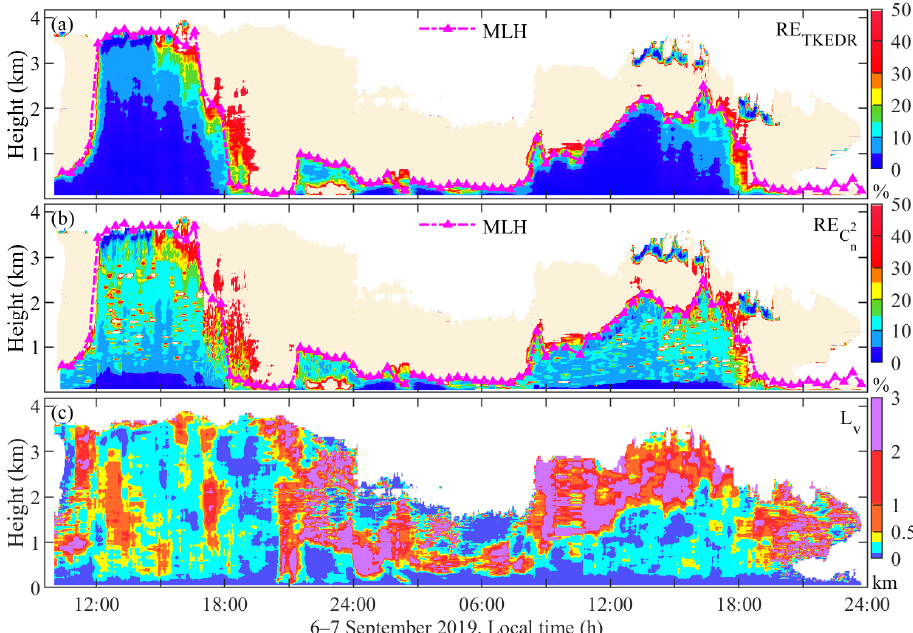
Figure 8. The relative error of the estimation of TKEDR ( a ), combined C 2 n ( b ), mixing layer height (MLH, ( a , b )), and integral scale L v ( c ) calculated from CDWL and MWR in the observations from 6 September to 7 September 2019, local time.